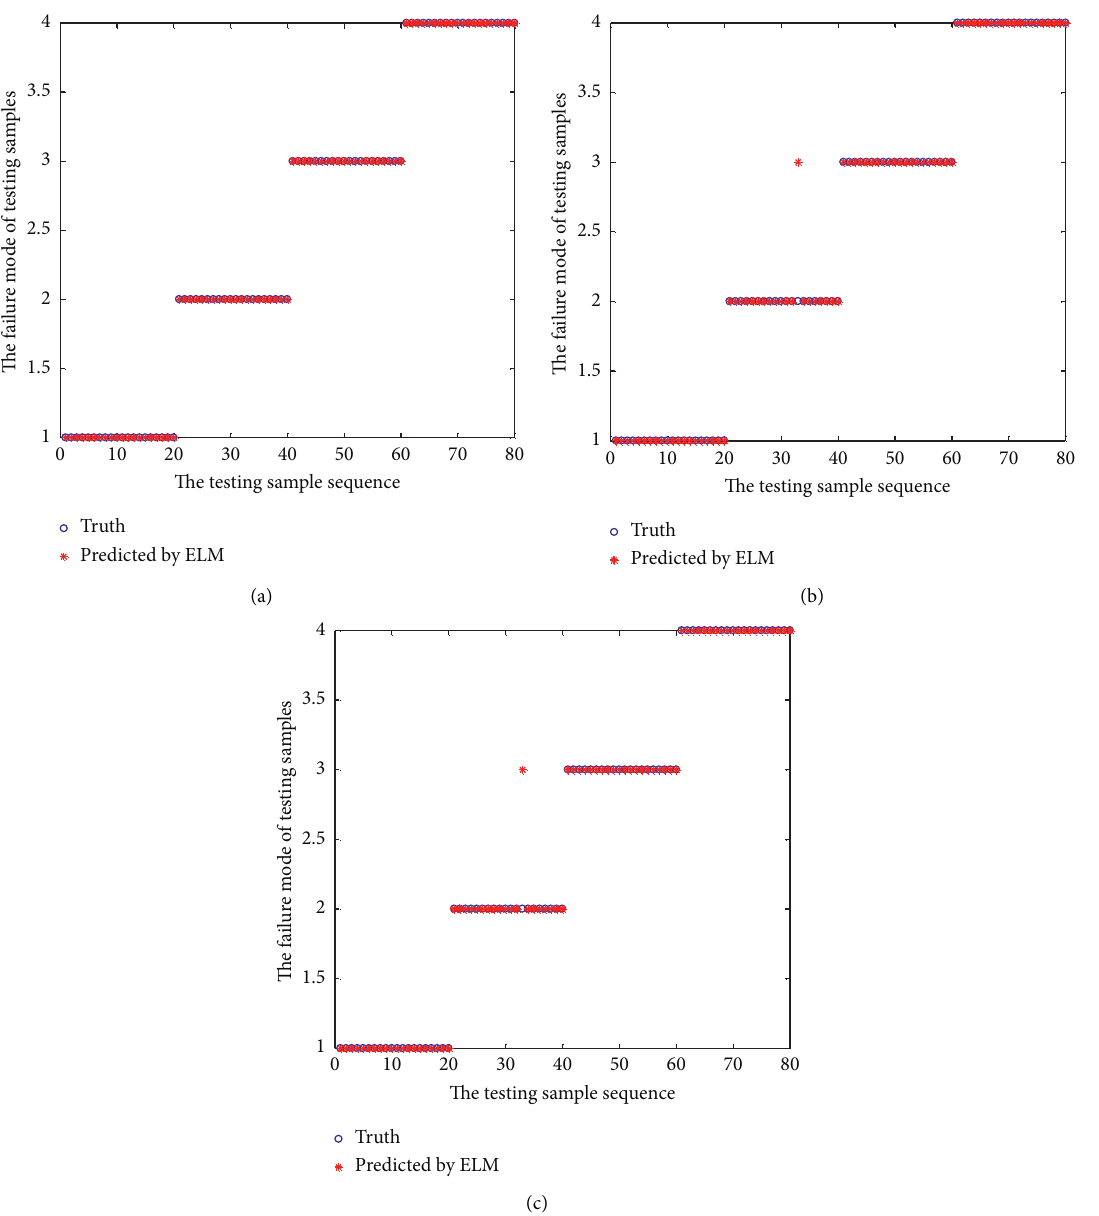
Figure 9: ELM recognition results of three feature extraction methods. (a) MPE-LPP-ELM. (b) MPE-PCA-ELM. (c)